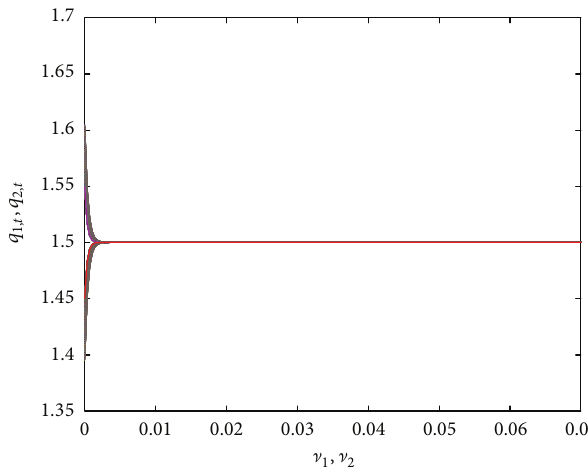
Figure 5: Behavior of 𝑞 1,𝑡 and 𝑞 2,𝑡 at the parameters: 𝑎 = 8 , 𝑐 = 2 , = 2.5 , 𝑞 = 0.5 , and 𝜂 = 0.9 . 𝑏 = 1 , 𝑞 0,1 0,2